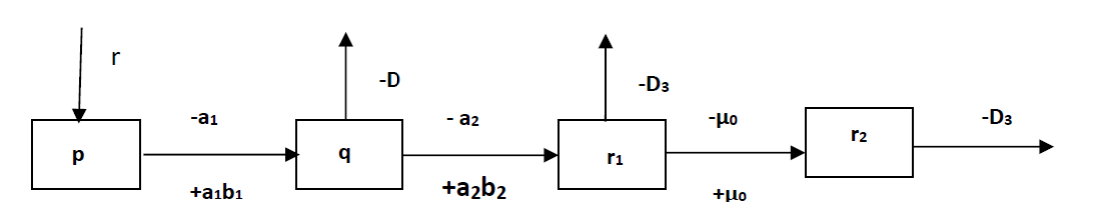
Figure 1. Graphical representation of model